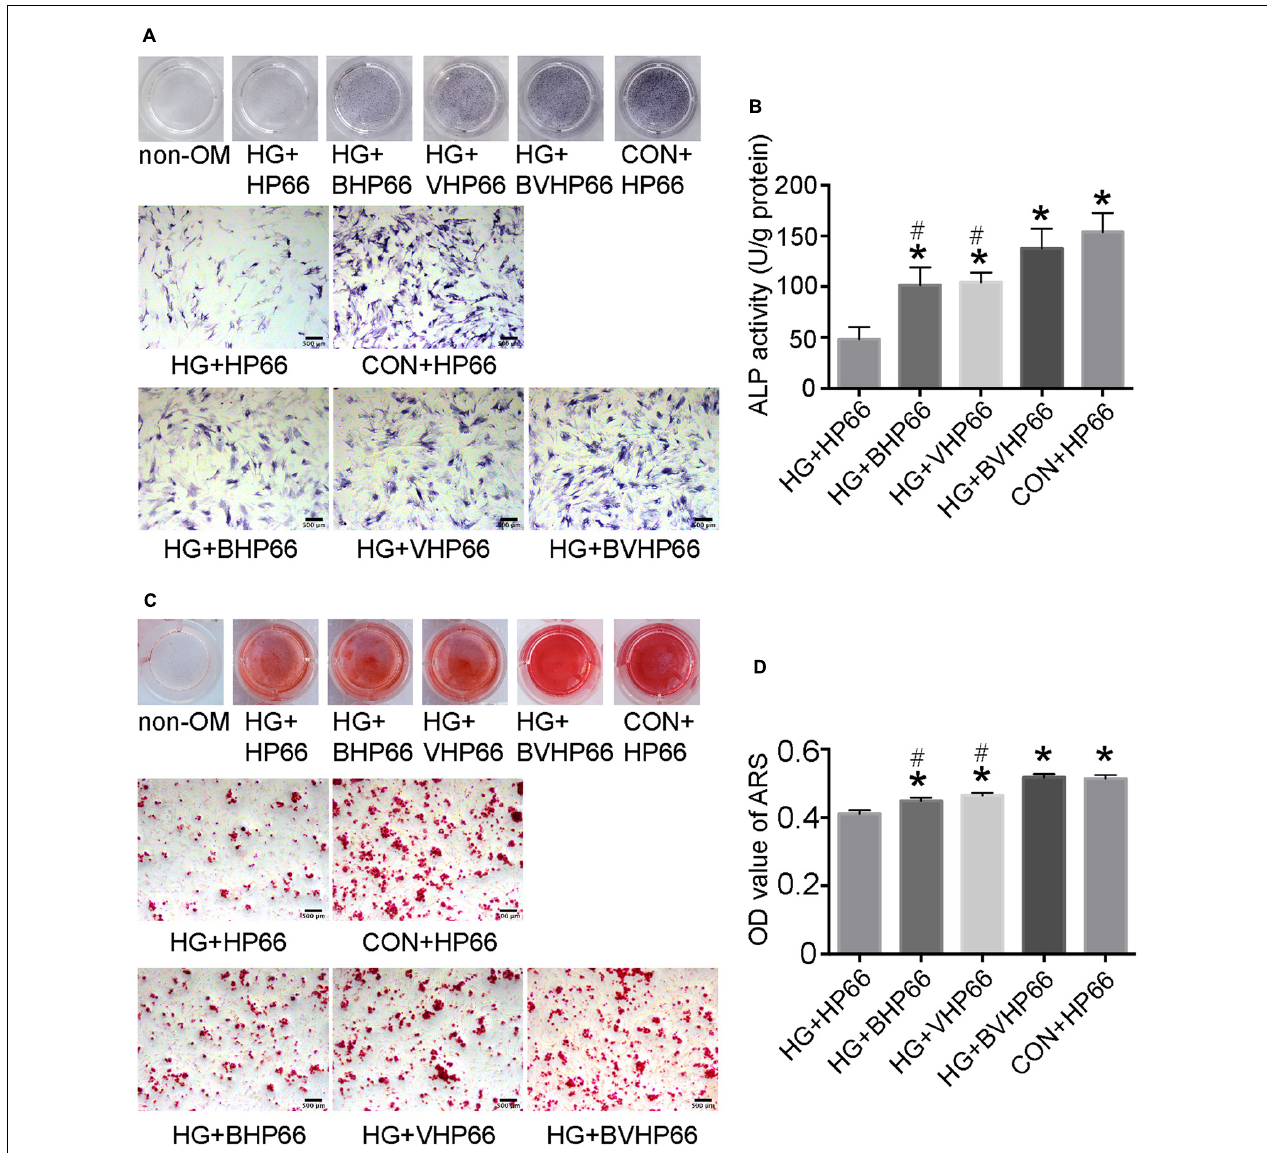
FIGURE 6 | Osteogenic differentiation of rBMSCs. (A) ALP staining and (B) ALP activity were evaluated on day 7 after cultured in osteogenic medium. (C) The ARS staining and (D) the quantitative mineralization assay were conducted on day 14 after cultured in osteogenic medium. Scale bar = 500 µ m. n = 3 for each group, data were expressed as mean ± SD. * P < 0.05, vs. HG + HP66 group; # P < 0.05, vs. HG + BVHP66